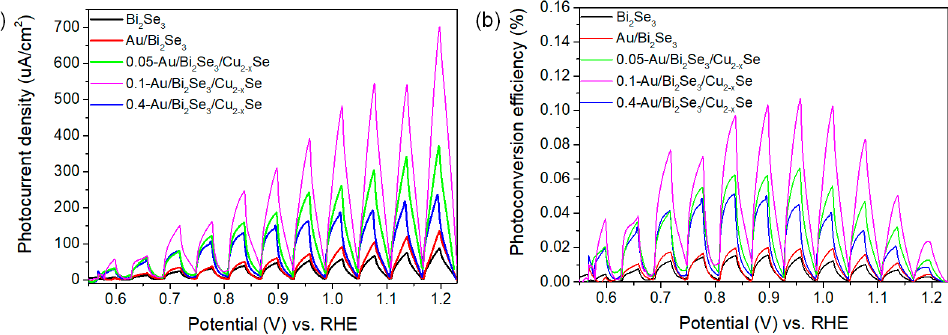
Figure 5. ( a ) Linear sweep voltammogram measurements and ( b ) calculated photoconversion effi- ciencies of Bi 2 Se 3 , Au/Bi 2 Se 3 and x -Au/Bi 2 Se 3 /Cu 2-x Se electrodes under the chopped sunlight illumi- nation.